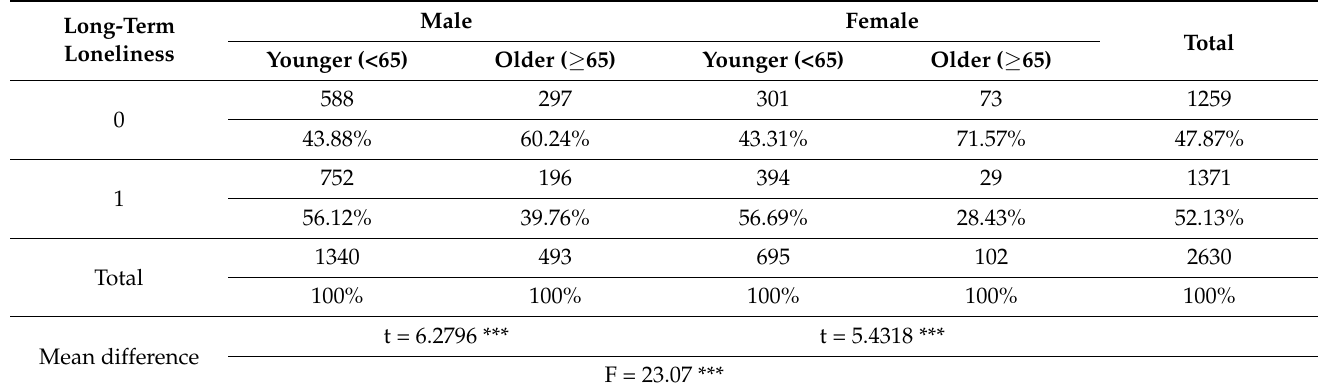
Table 3. Distribution of long-term loneliness by gender and age group.